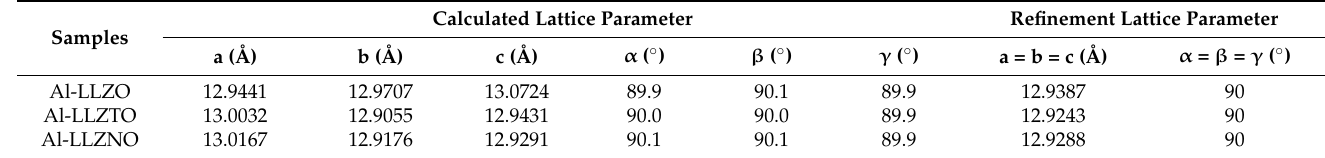
Table 3. Lattice parameters for calculated crystals and XRD